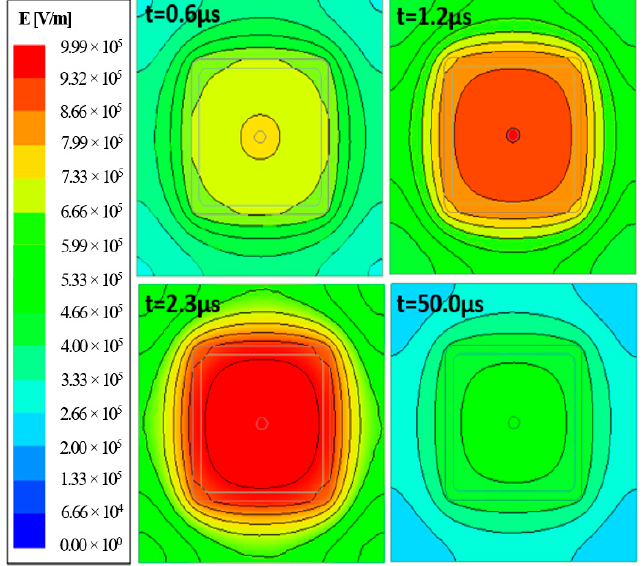
Figure 13. E ‐ field at different time moments. Translated into curves, the sample’s E ‐ field measurements across the y ‐ axis (or y cross section) were labeled Y1, Y2, and Y3 and represented by a “dome shape” (refer to Figure 14). The profiles showed that the maximum E ‐ field on the outer surface of GFRP was slightly lower than the internal surface, marking a 1.32% difference. In contrast, 10.02% of the difference was measured between the outer surface and foam. In general, it could be observed that the magnitude of the E ‐ field presented in Figure 14 exceeded the typical streamer threshold that is usually initiated at a magnitude of 0.50 MV/m to 0.60 MV/m [29–31].